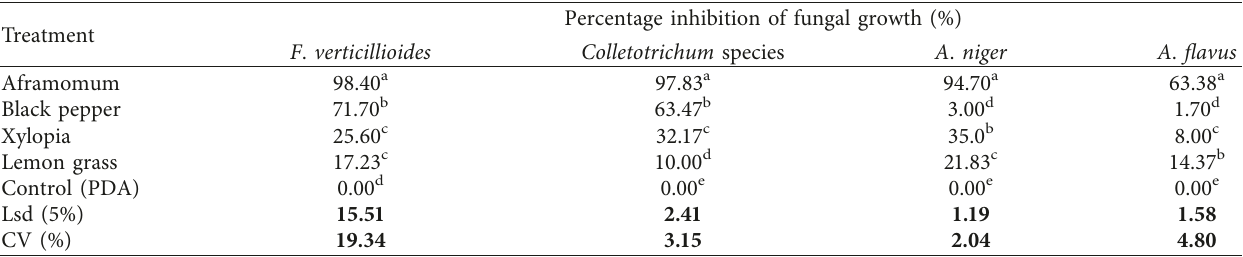
Figure 4: Growth inhibition by Aframomum melegueta extract and their corresponding controls: (a) Fusarium verticillioides , (b) Col- letotrichum species, (c) Aspergillus niger , and (d) Aspergillus flavus . Table 2: Inhibition of fungal growth by the aqueous botanical